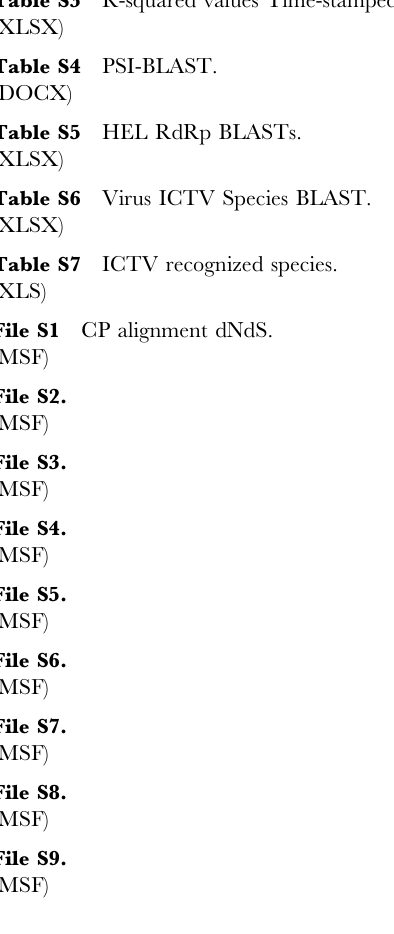
Table S3 R-squared values Time-stamped vs. Random. Table S4 PSI-BLAST. Table S5 HEL RdRp BLASTs. Table S6 Virus ICTV Species BLAST. Table S7 ICTV recognized species.